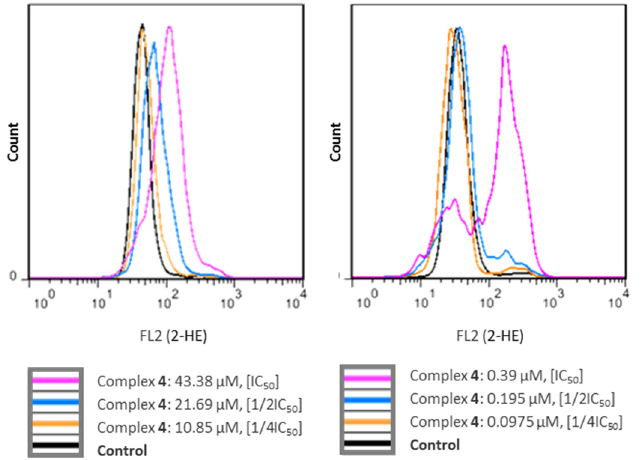
Figure 10. Generation of ROS induced by complex 4 at increasing concentrations in dark ( left graph ) and upon irradiation at 470 nm ( right graph ).